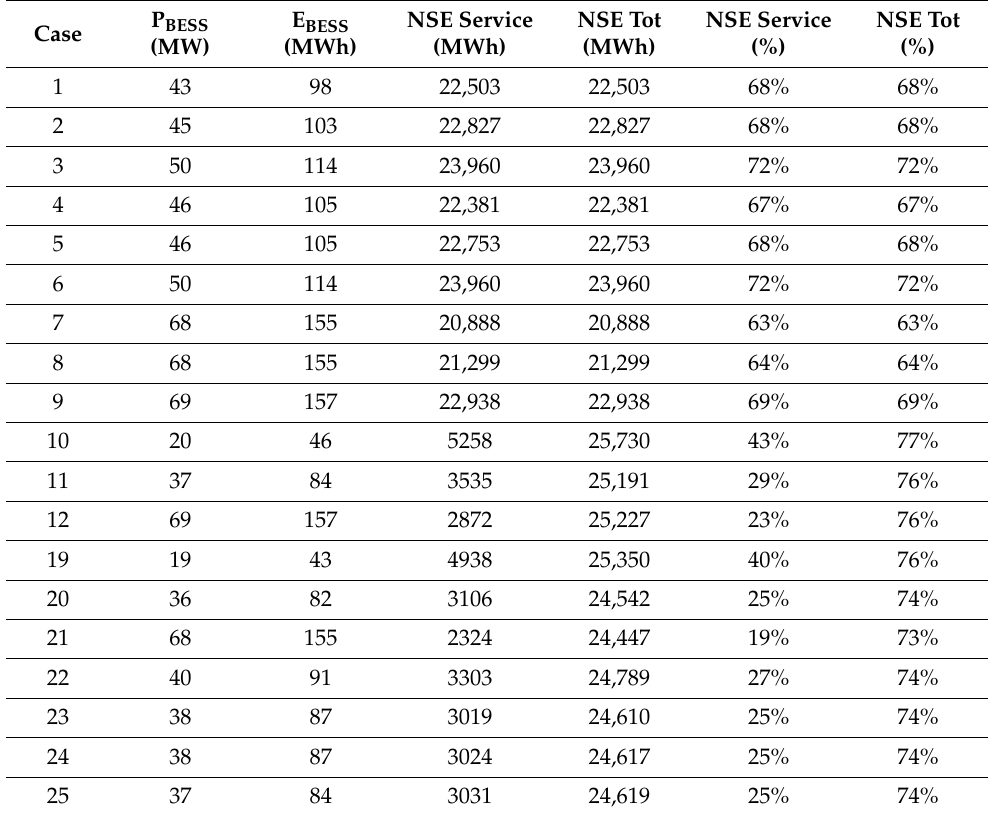
Table 4. The MILP optimization